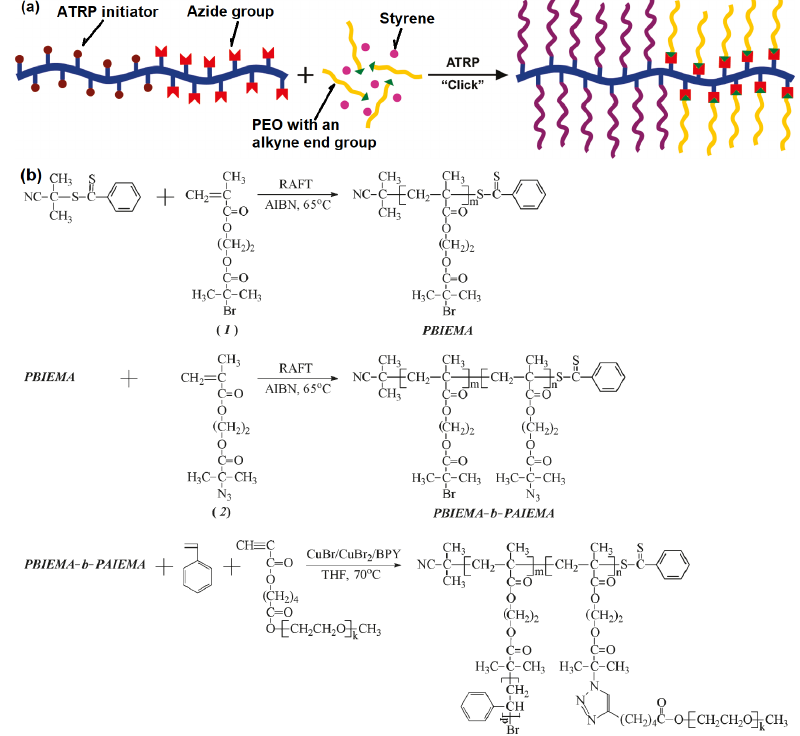
Figure 11. Synthesis of bottlebrush block copolymer by concurrent ATRP and CuAAC click chemistry. Adapted with permission from [66], Copyright© 2011 American Chemical Society.